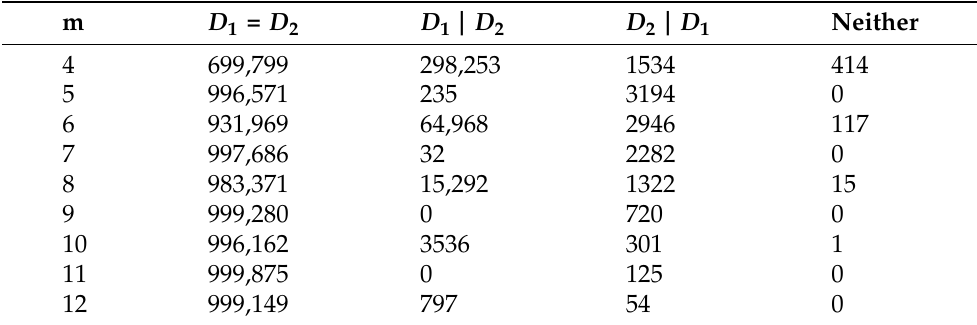
Table 6. Data for m = 4.12, based on a million random permutations of length m from the first 100,000